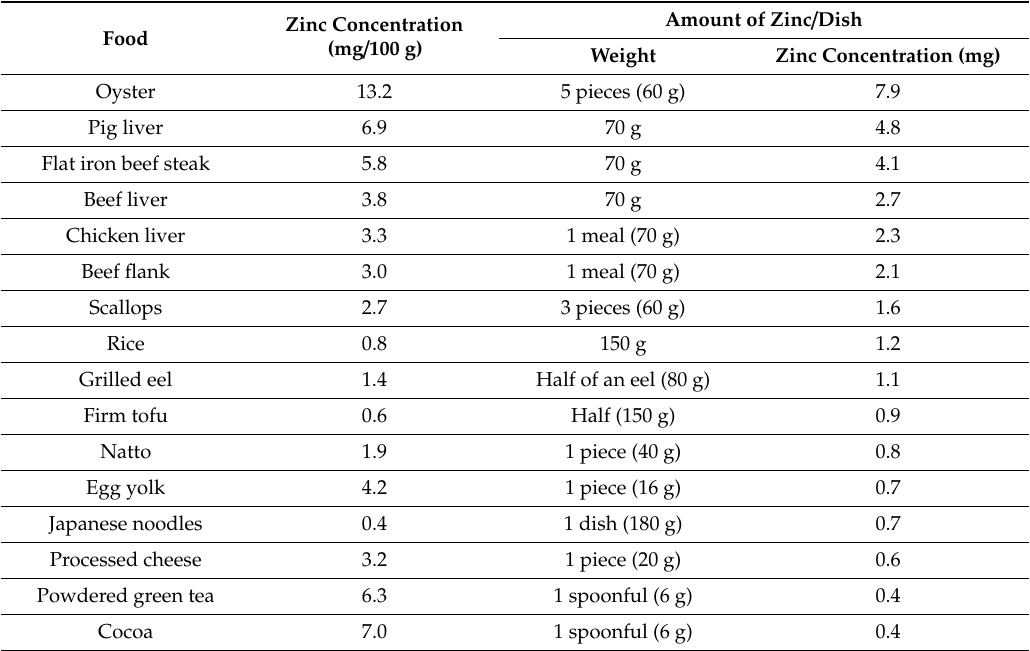
Table 2. Foods rich in